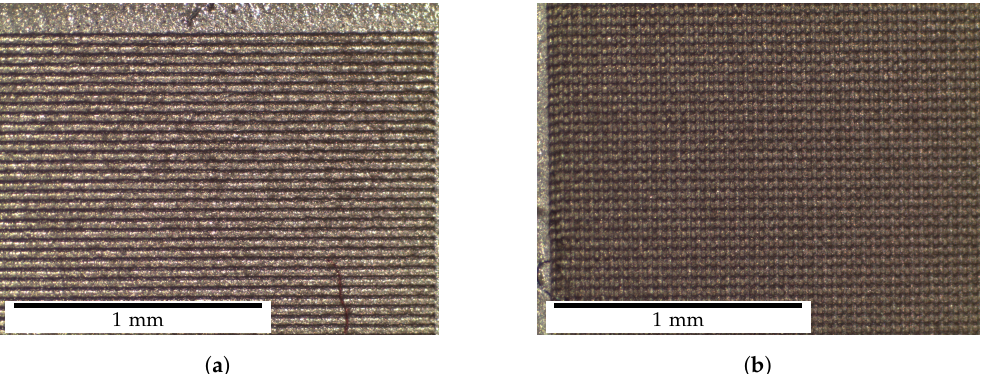
Figure 6. Optical microscope images of 1 tion. ( a ) Lamellar structures. ( b ) Pillared